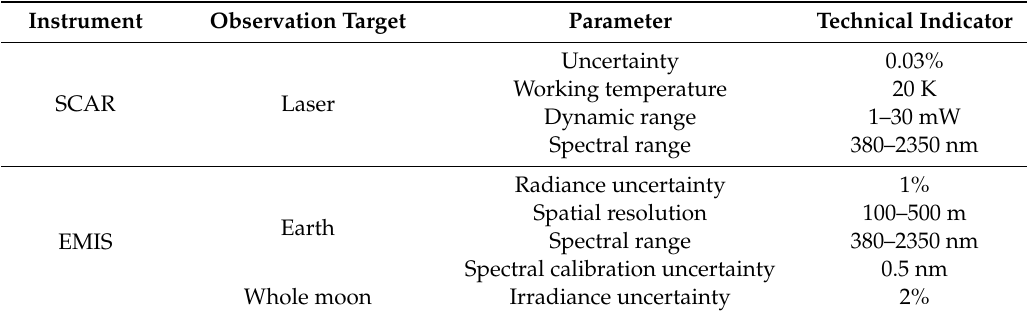
Table 1. The goal of the radiometric benchmark on the reflected solar band. SCAR: Space Cryogenic Absolute Radiometer; EMIS: Earth–Moon Imaging